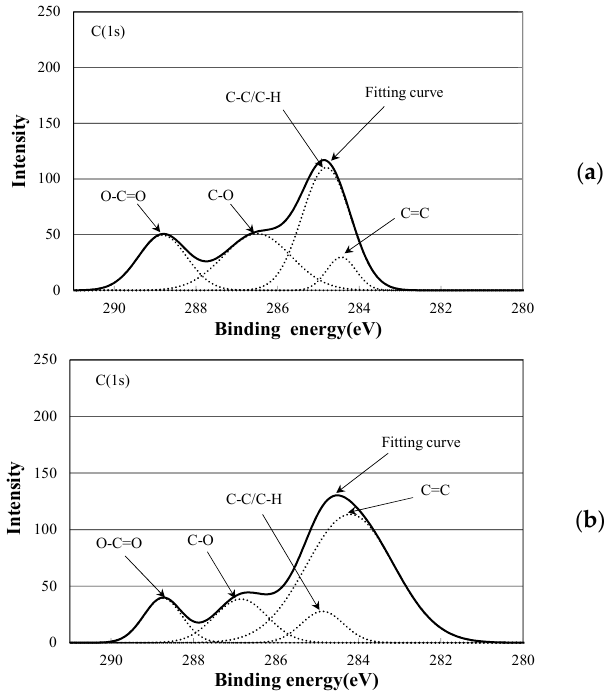
Figure 8. C1s spectrum of PLA ‐ 0 at ( a ) 0 Gy; ( b ) 100 kGy.